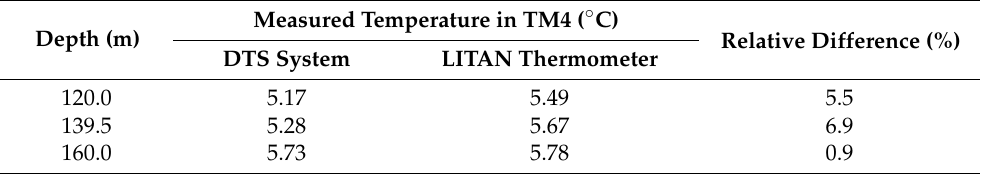
Table 2. Comparative analysis of temperature measurements in TM4. Depth